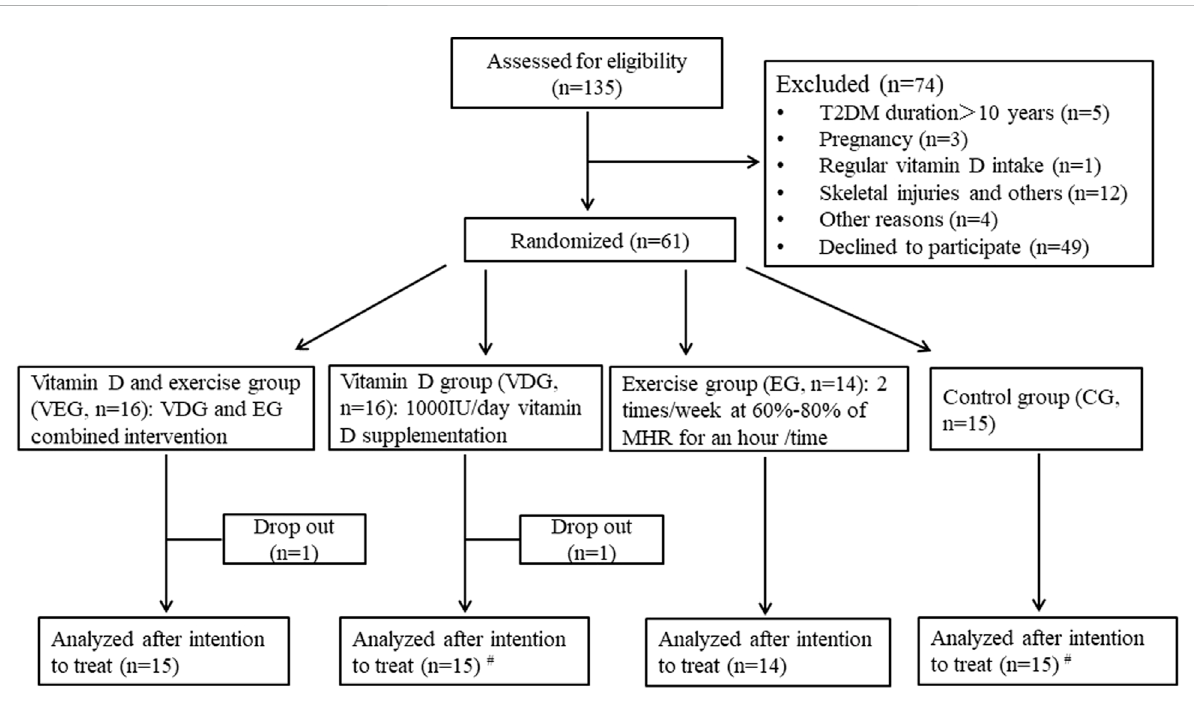
FIGURE 1 Flow diagram of participants. # One participant in the vitamin D supplementation group had incomplete dual-energy X-ray absorptiometry and physicalperformancemeasurements,andanotherinthecontrolgroupdidhadincompletedual-energy X-rayabsorptiometrymeasurements.MHR, maximum heart